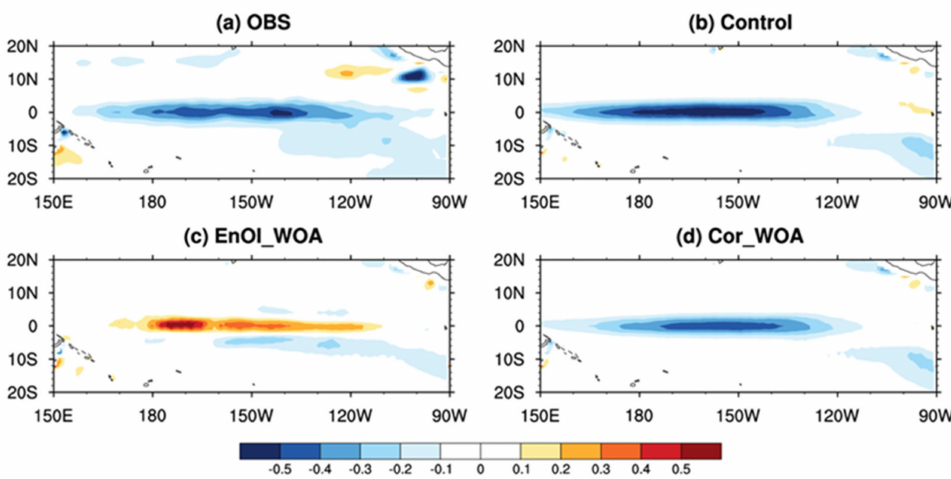
Figure 9. Spatial distribution of u*dT/dx in the tropical Pacific: ( a ) OBS; ( b ) Control; ( c ) EnOI_WOA; ( d )